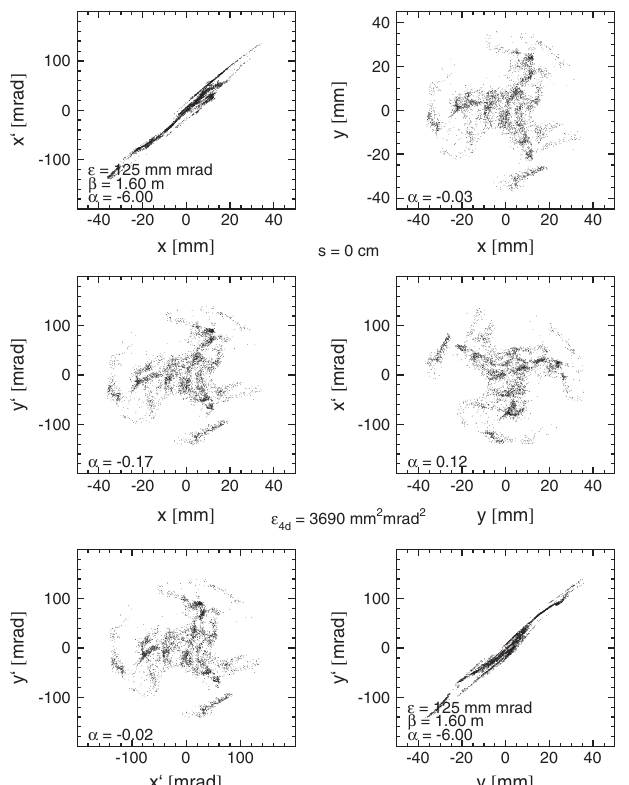
FIG. 1. Two-dimensional projections of the ECR transverse phase space distribution at the entrance to the emittance transfer section. Horizontal and vertical rms Twiss parameters are in- dicated as well as the four interplane correlation parameters.